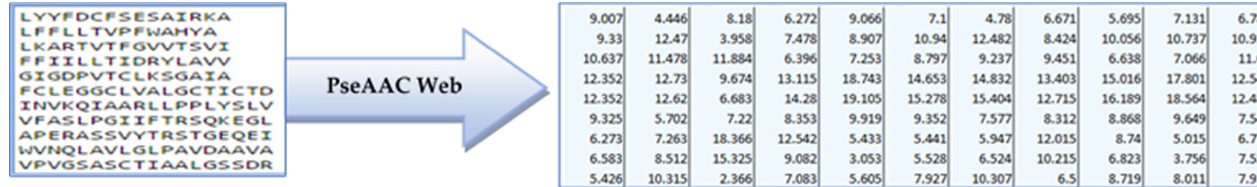
Figure 2. Features extracted from anti-HIV-1 peptide sequence.